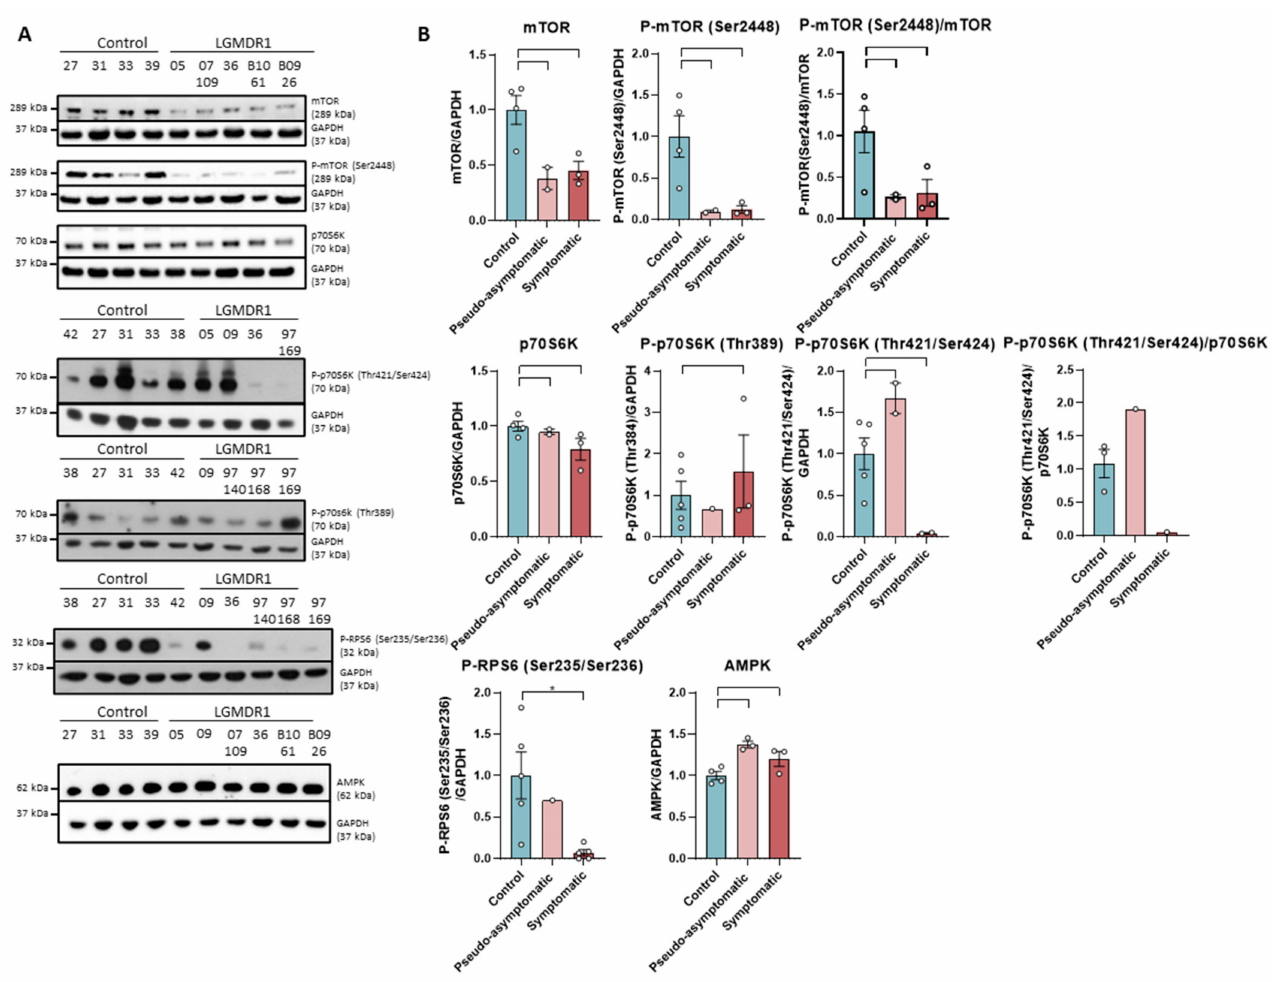
Figure 2. Western blot ( A ) and densitometry analysis ( B ) mTOR signaling pathway proteins in samples from muscles of LGMR1 and controls: mTOR, P-mTOR (Ser2448), mTOR/P-mTOR (Ser2448), p70S6K, P-p70S6K (Thr389),